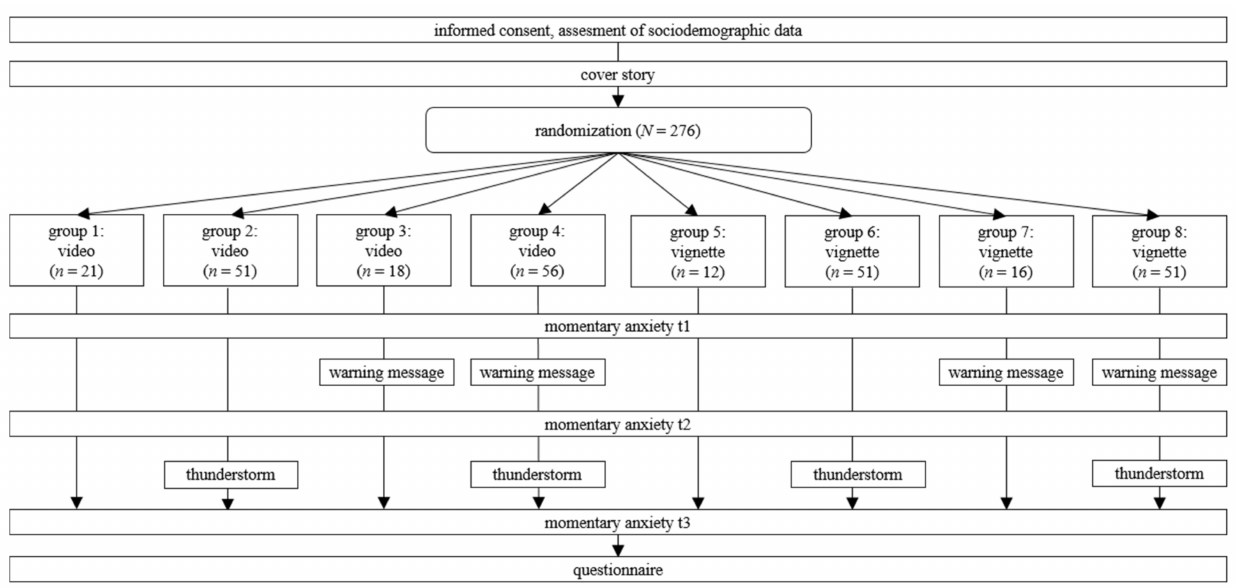
Figure 2. Study procedure: Participants were randomized into eight groups according to presentation format (video vs. vignette), warning receipt (no warning vs. warning), and thunderstorm exposure (no thunderstorm vs. thunderstorm). Momentary anxiety was assessed at three time points: t1 (beginning of the cover story), t2 (warning message receipt vs. no receipt), t3 (thunderstorm exposure vs. no